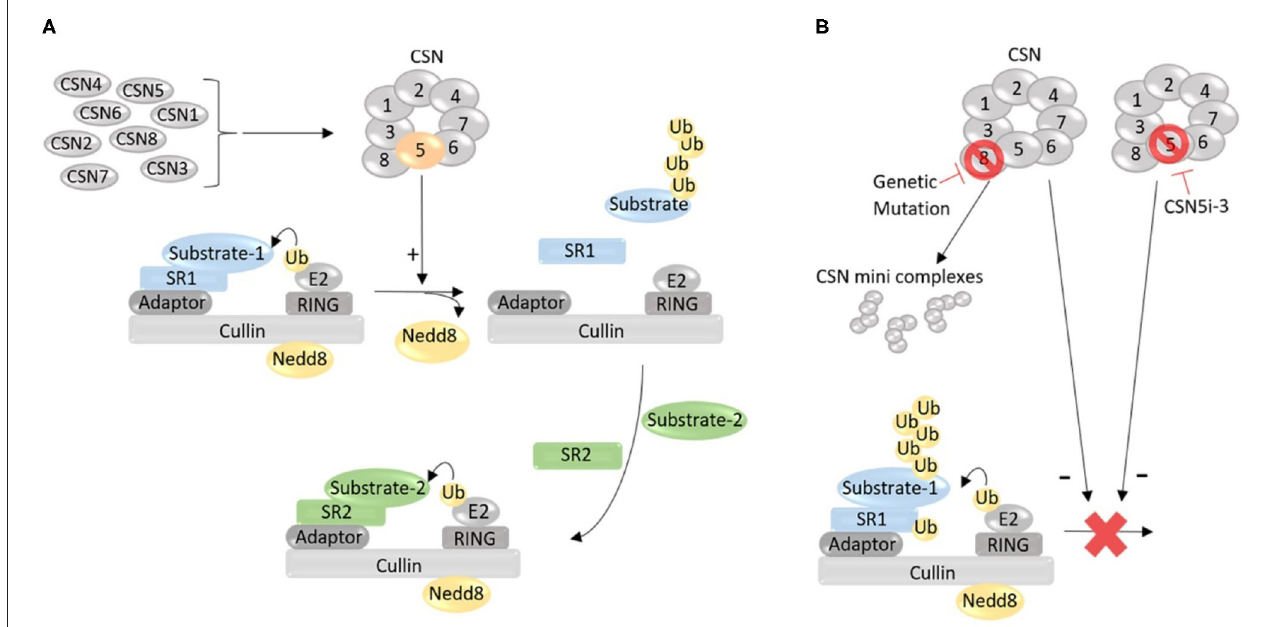
FIGURE 1 | A working model for the role of the COP9 signalosome (CSN) in the regulation of the catalytic dynamic of Cullin-RING ligases (CRLs). (A) Under normal condition, the CSN holocomplex formed by eight unique protein subunits (CSN1 through CSN8) removes the Nedd8 from the neddylated Cullin, thereby inactivates and dissembles the CRL that has completed ubiquitinating a substrate protein (Substrate-1) recruited by substrate receptor 1 (SR1), allowing for the formation of a new CRL with a new SR (SR2) to recruit a new substrate (Substrate-2) for ubiquitination. (B) Defect in the formation of the CSN holocomplex, such as depletion of a subunit due to genetic mutation, may increase the abundance of certain species of minicomplexes composed of some of the CSN subunits but reduces or loses the deneddylase activity, impairing Cullin deneddylation; Cullin deneddylation by the CSN can also be inhibited by small molecules (e.g., CSN5i-3). When Cullin deneddylation is lost, the exchange of SRs in CRLs will be compromised, and as a result, the catalytic dynamic of CRLs will be stalled, leading to autoubiquitination and destruction of CRL components (e.g.,